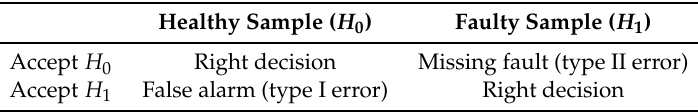
Table 4. Guide for the presentation of the results in Table 5.